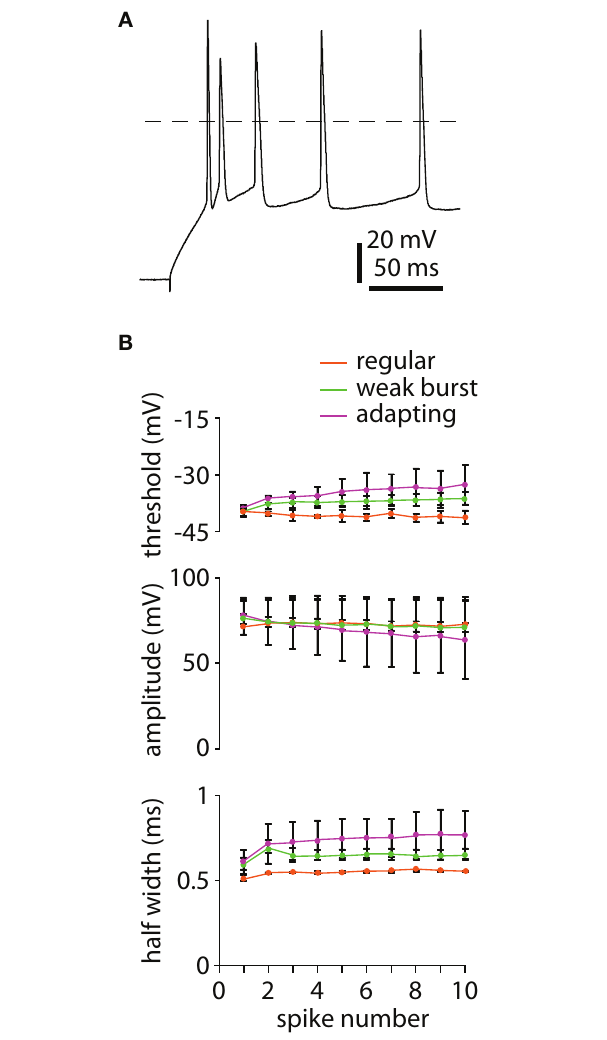
FIGURE 4 | Changes in action potential waveform during a train of spikes. (A) Example of a recording in which spike threshold, amplitude, and half width change during a spike train. Layer 6 neuron with adapting spike pattern at 24–26 ◦ C. (B) Spike threshold, amplitude, and half width for the first 10 spikes during 600ms constant current injection at 36–37 ◦ C in layer 2/3 pyramidal neurons. Neurons were grouped according to spike pattern, with adapting, weak bursting, and regular spiking patterns in pink, green, and orange, respectively. Points represent the mean ( ± SEM) from two neurons with adapting patterns, six with weak bursting patterns, and two with regular spiking